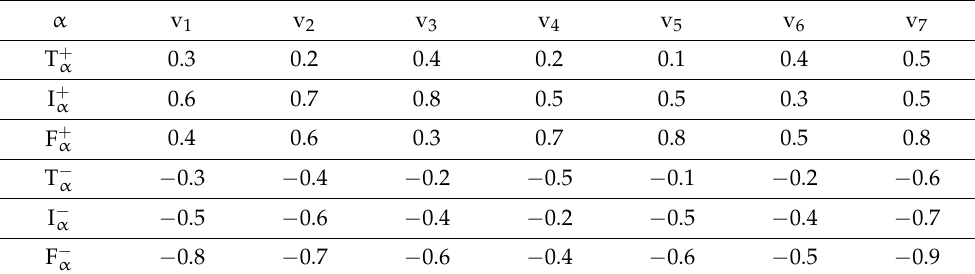
Table 4. Laplacian energy of BSVNG set on V.